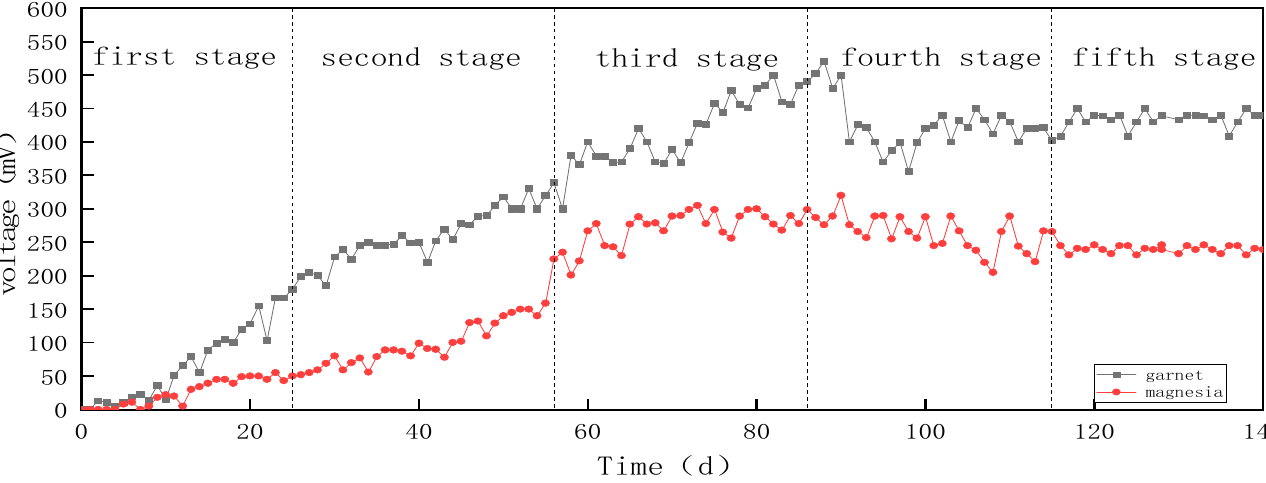
CW-MFC CW Figure 2. Phosphorus removal by the CW and CW-MFC systems. ( a ) Constructed system based on garnet; ( b ) constructed system based on magnesia. 2.2. Power Generation Performance of the CW-MFC System The system operation was divided into five stages. The two CW-MFCs based on mag-